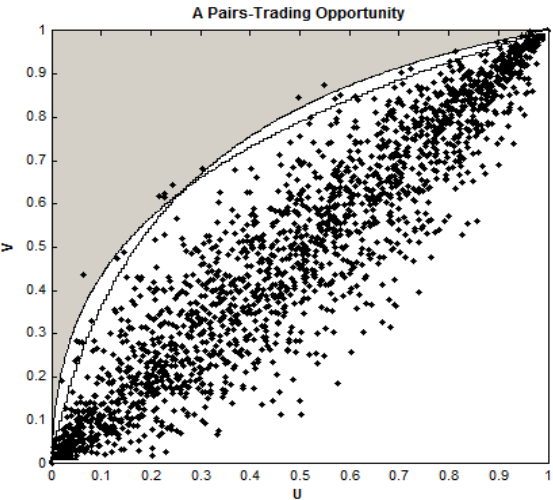
FIGURE 4: An illustration of the area where pairs-trades can be executed when using a 99% confidence level and the N14 copula dependence